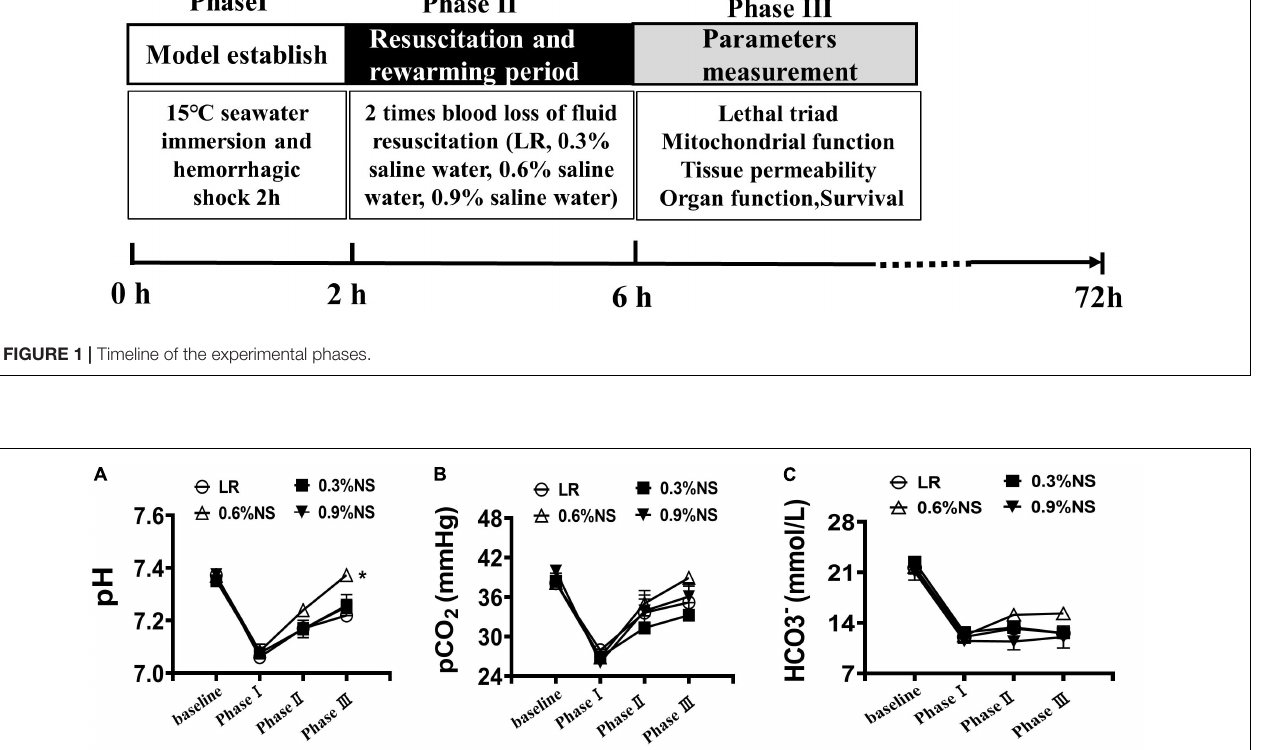
Frontiers in Physiology |